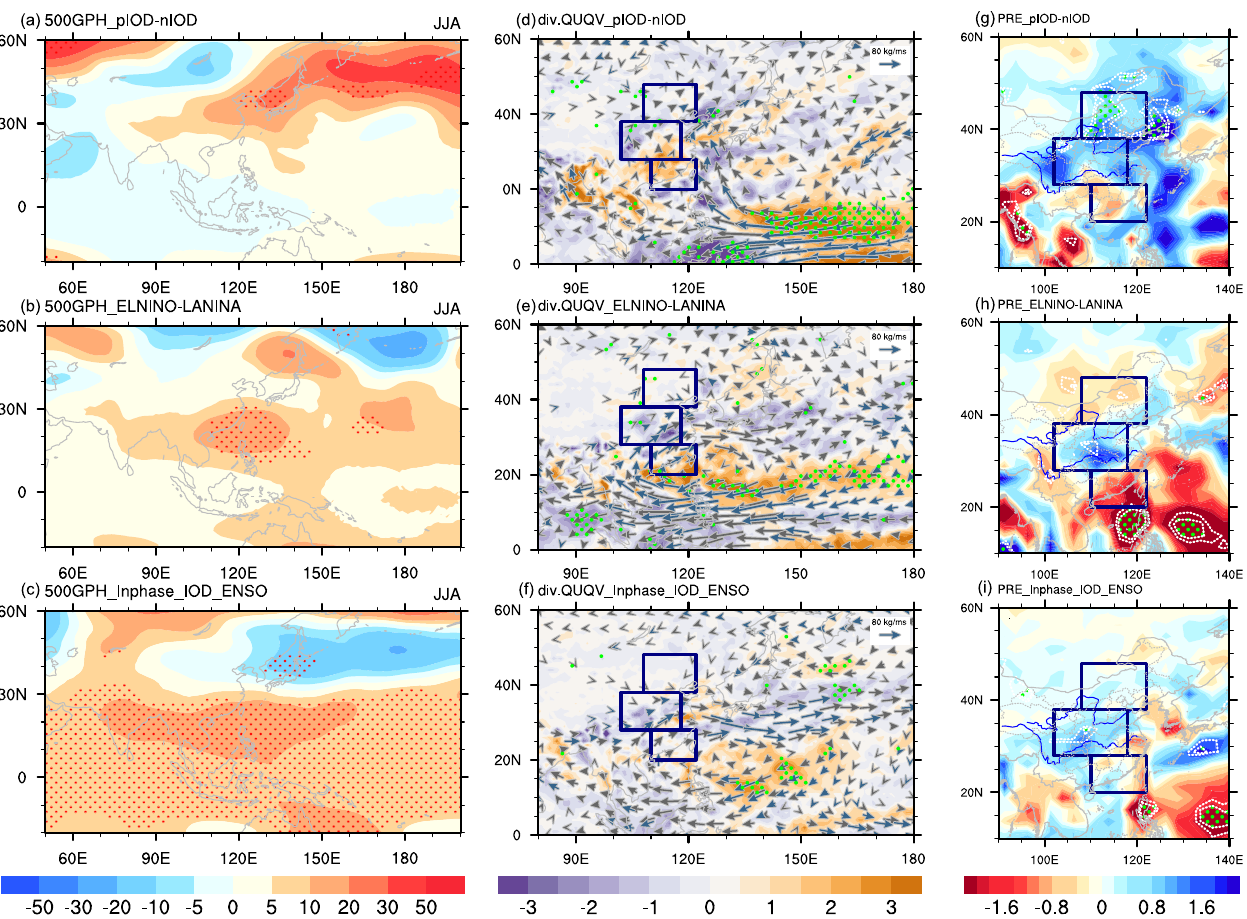
Fig. 2 Composites of atmospheric fi elds associated with the preceding IOD and ENSO. Composite difference of a – c geopotential height (shading; m 2 s − 2 ) at 500 hPa during the ensuing summer based on the years when a only IOD occurs, b only El Niño occurs, and c IOD and ENSO occur together. d – f as in a – c but for vertically integrated water vapor fl ux (vectors, kg m − 1 s − 1 ; showing only values greater than 10 kg m − 1 s − 1 ) and its convergence (shading; kg m − 2 ). g – i as in a – c but for precipitation (mm day − 1 ). Dotted areas mean that signals are statistically signi fi cant at the 95% con fi dence level. Blue vectors in d – f indicate that the vertically integrated water vapor fl ux exceeds the 95% con fi dence level. Boxes in d – i indicate the key regions for water vapour budget analysis.